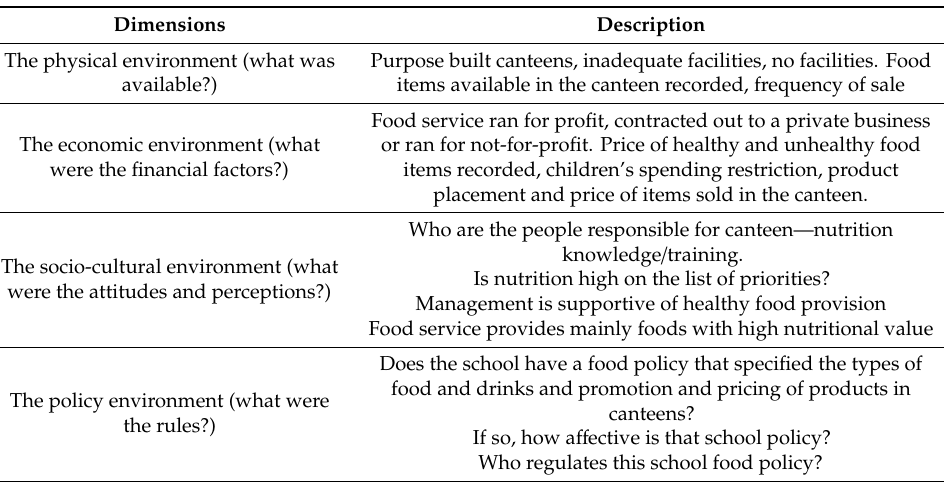
Table 1. The four environmental dimensions used to group the food environment measurement methods (adapted from Swinburn et al. [33]).